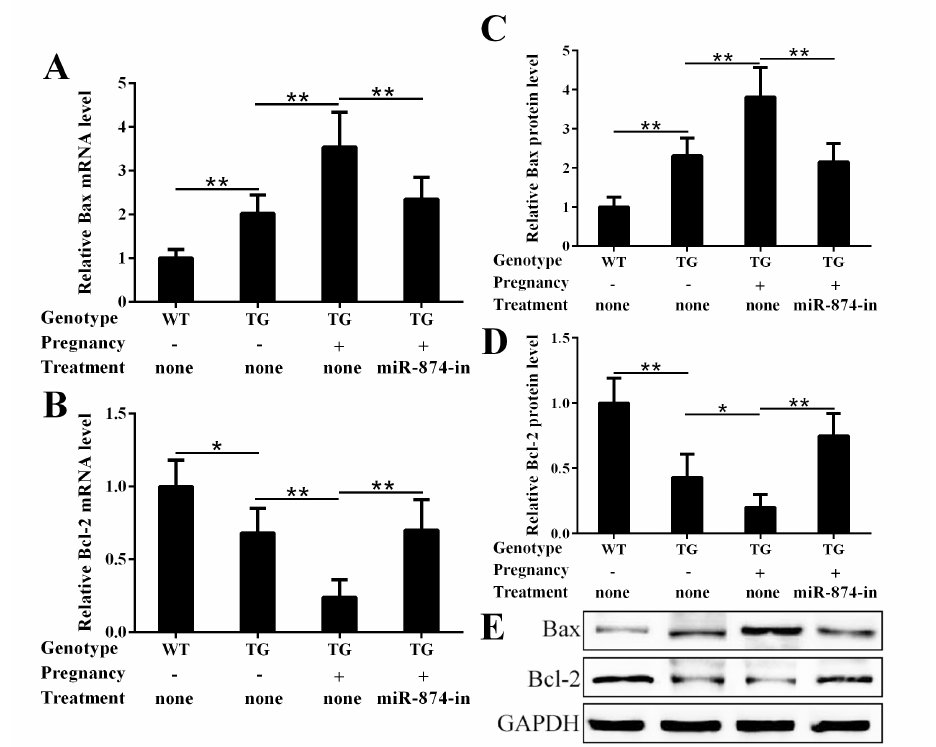
Figure 5. Inhibition of miR-874 ameliorated cardiomyocyte apoptosis in PPCM of Gαq transgenic mice. QRT-PCR was used to measure the mRNA levels of Bax (A) and Bcl-2 (B) from left ventricular myocardial tissues among different groups. Western blotting was used to measure the protein levels of Bax and Bcl-2 from left ventricular myocardial tissues among different groups (C-E). Age- matched, female non-pregnant wild-type (WT, n=18) and Gαq transgenic mice (GT, n=18), pregnant Gαq transgenic mice (n=8) and Gαq transgenic mice treated with miR-874 antagonist (miR-874-in, n=15) were compared. Data are presented as mean ± SD. *p < 0.05, **p < 0.01 between the indicated